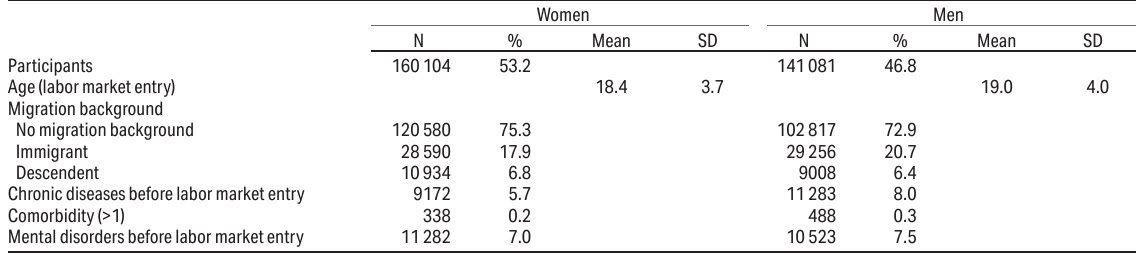
Table 1. Participant characteristics. [SD=standard